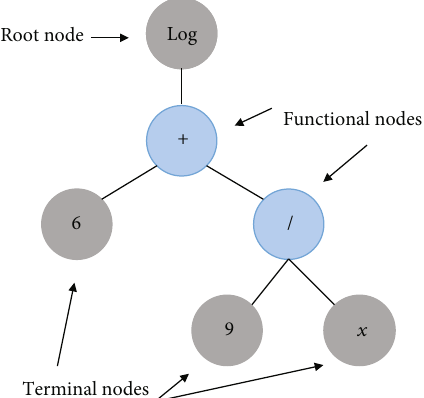
Figure 2: Tree representation of the model y = log ð 6 + 9/ x Þ